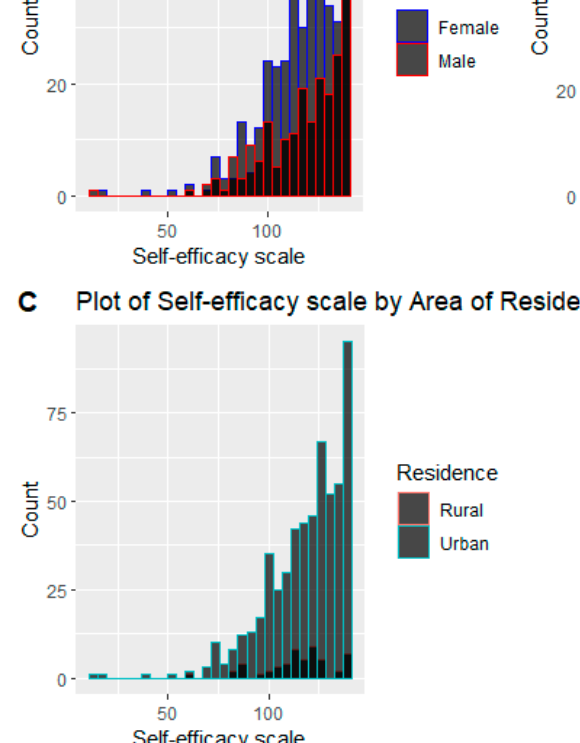
Figure 2. ( A – C ) Distribution of self-efficacy by demographic factors.